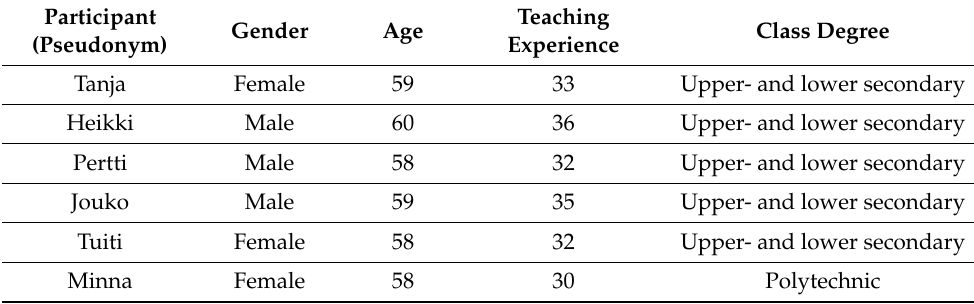
Table 1. General demographics of the